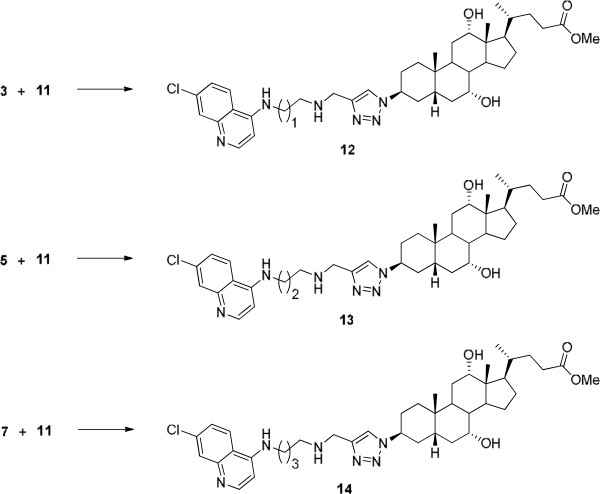
Reagents and conditions: (a) CuSO4.5H2O, sodium ascorbate, DMSO/H2O (1:1), 25°C, 96 h, 60%.